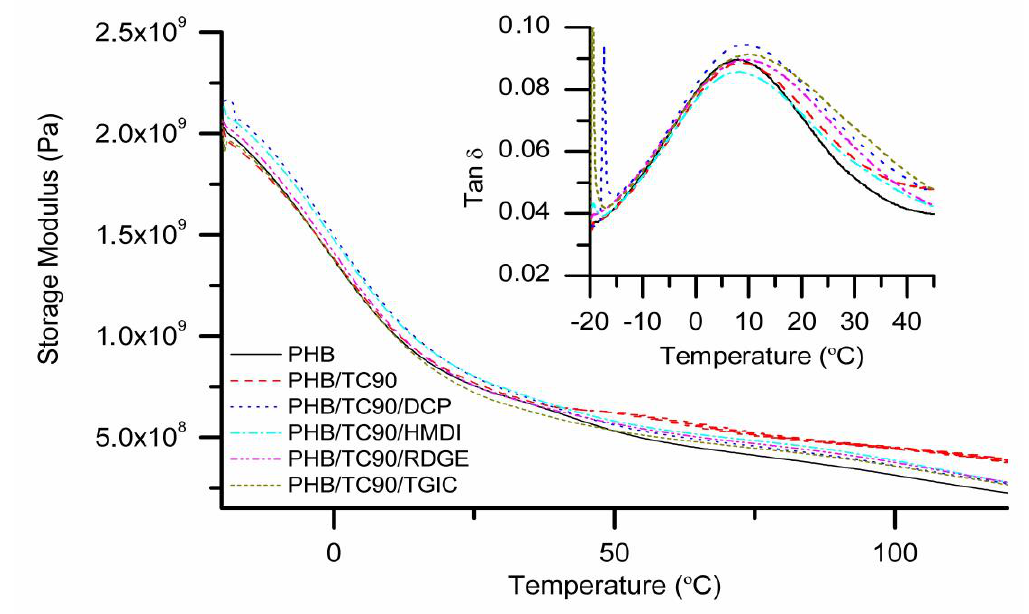
Figure 5. Storage modulus (G’) and tan δ (inset) evolution with temperature for neat PHB and PHB/TC90 composites with reactive agents.